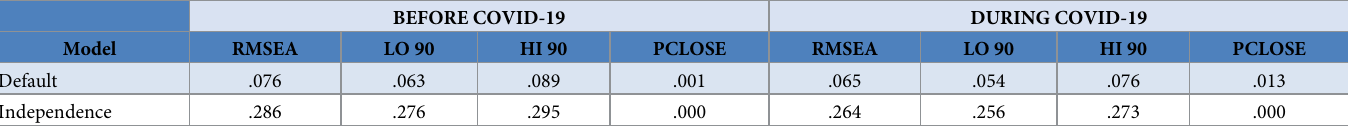
Table 5. RMSEA index.